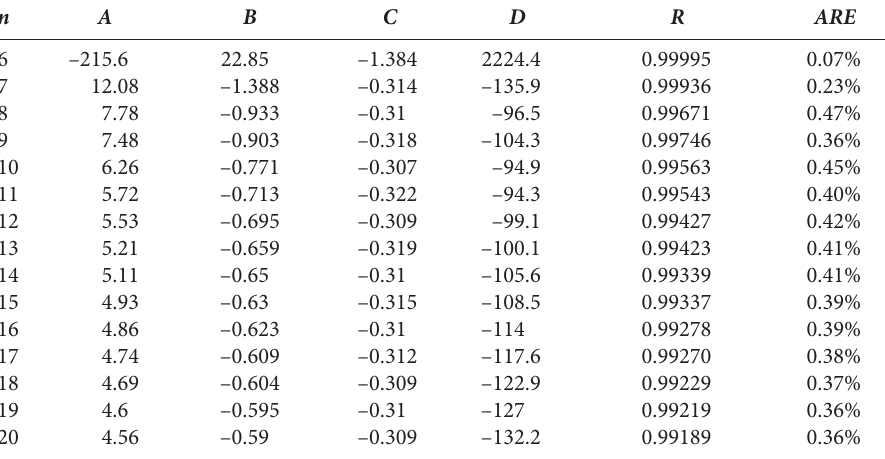
first Zagreb index and the number of zeros in the spectra of a graph are the parameters who largely influence the relationship between the Estrada index and the graph en- ergy in the case of trees. Thence, we conjectured that the energy of a graph could be modeled by the following for-